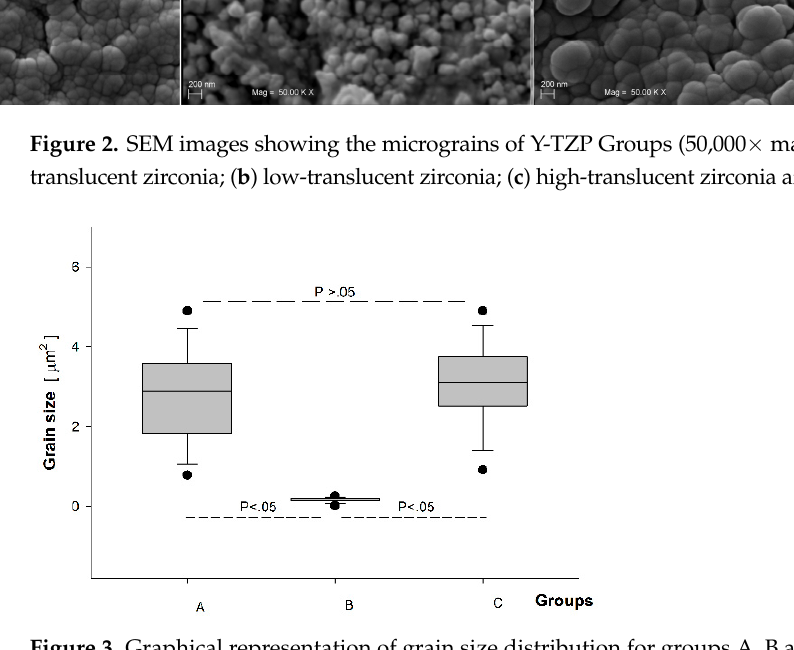
Figure 3. Graphical representation of grain size distribution for groups A, B and C.